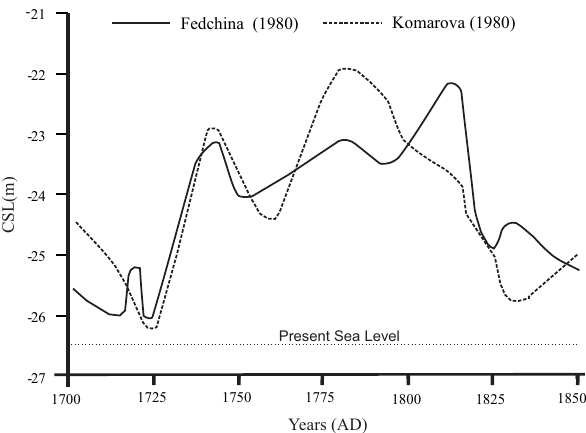
Fig. 5. The Caspian sea-level (CSL) changes during the eighteenth century and first half of the nineteenth century (Fedchina, 1980) and the sea-level curve from Komarova (1980) based on Russian cartographic maps.